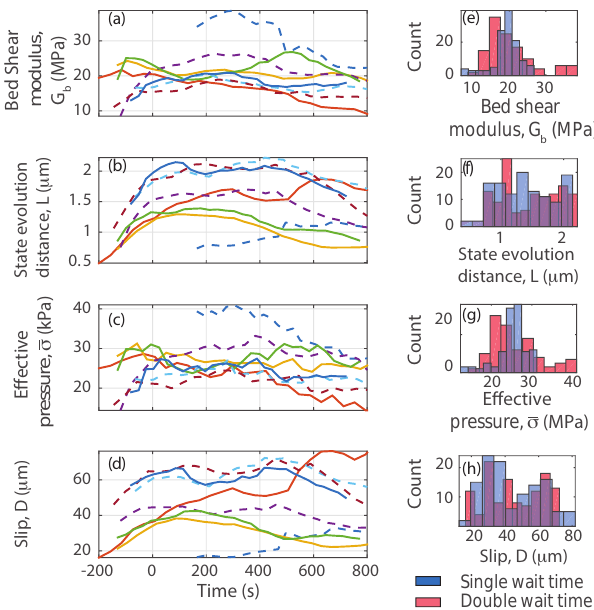
Figure 5. Time series of inferred parameters (a–d) and their his- tograms (e–h) for six tremor episodes. Properties of the events are listed in the table in Fig. 4g. The colors and symbols used in the time series and histograms are the same as in Fig.